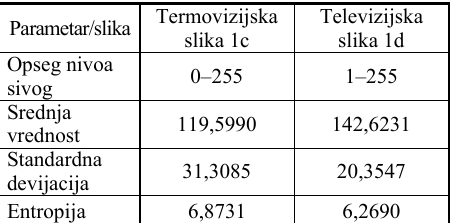
U tabeli 2 dati su: opseg nivoa sivog, srednja vrednost, standardna devijacija i entropija nivoa sivog za slike 1c i